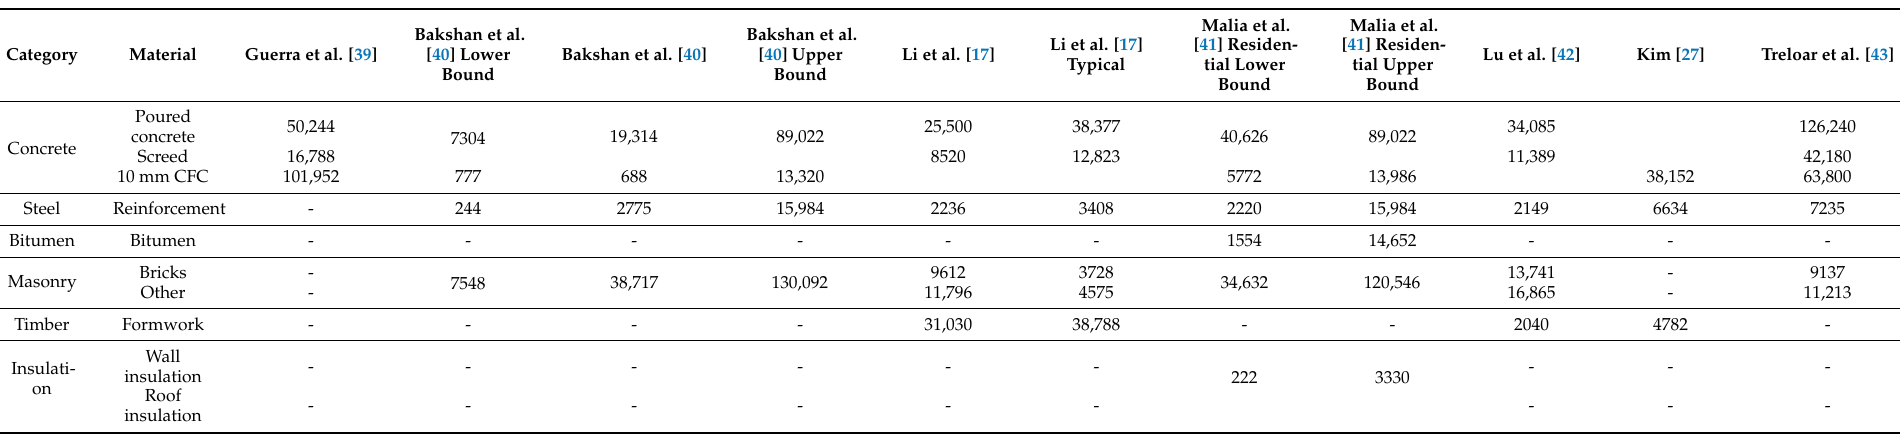
Table A2. Waste generation for Case B conventional construction based on literature